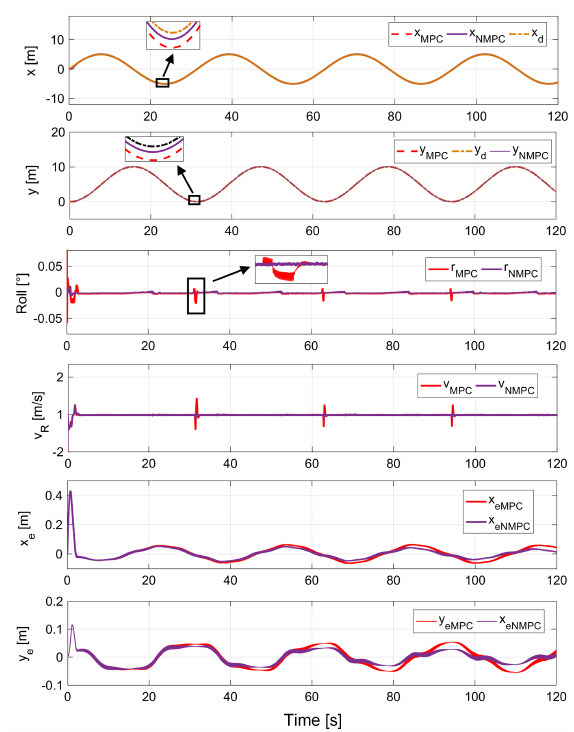
Figure 15. The comparative results of NMPC and MPC in longitudinal position, lateral position, roll angle, rollator velocity, longitudinal error, and lateral